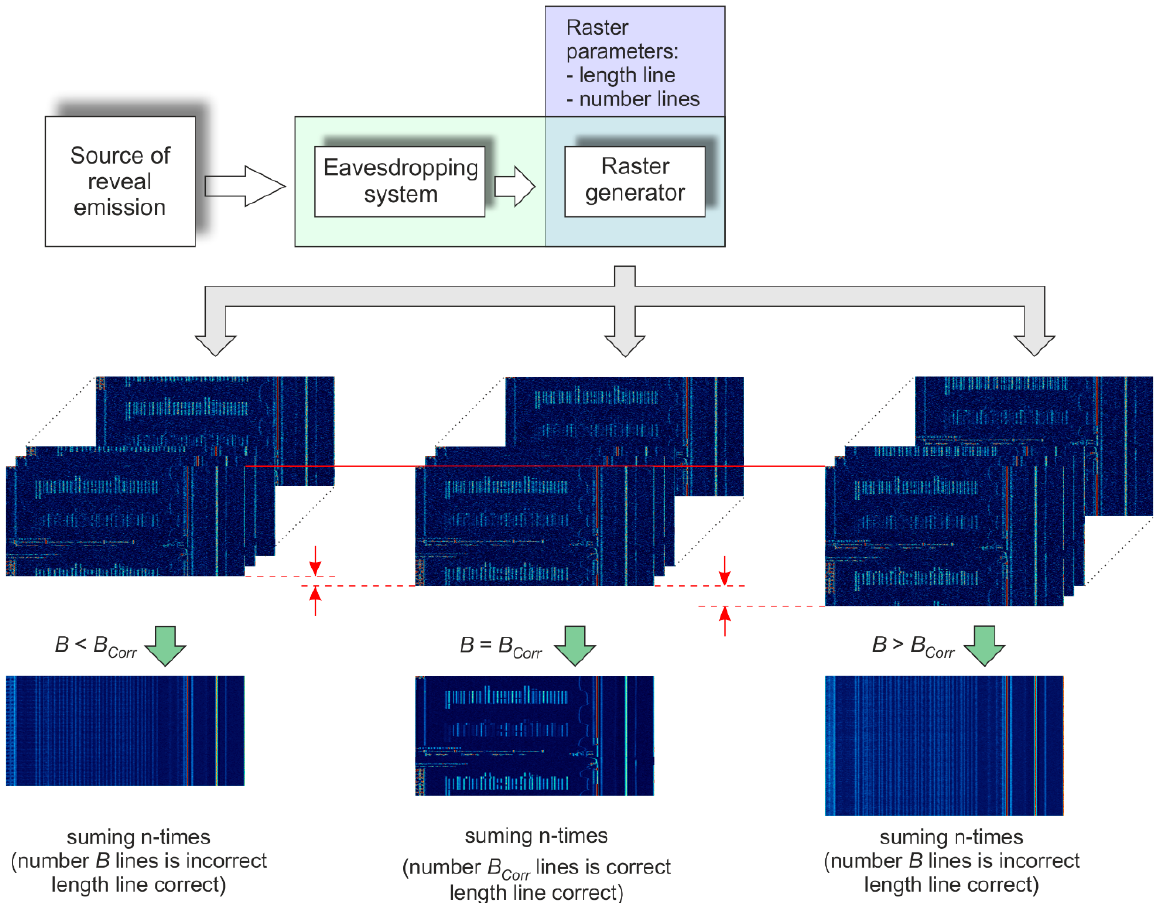
Figure 4. The working scheme of coherent summing of images in electromagnetic infiltration process.